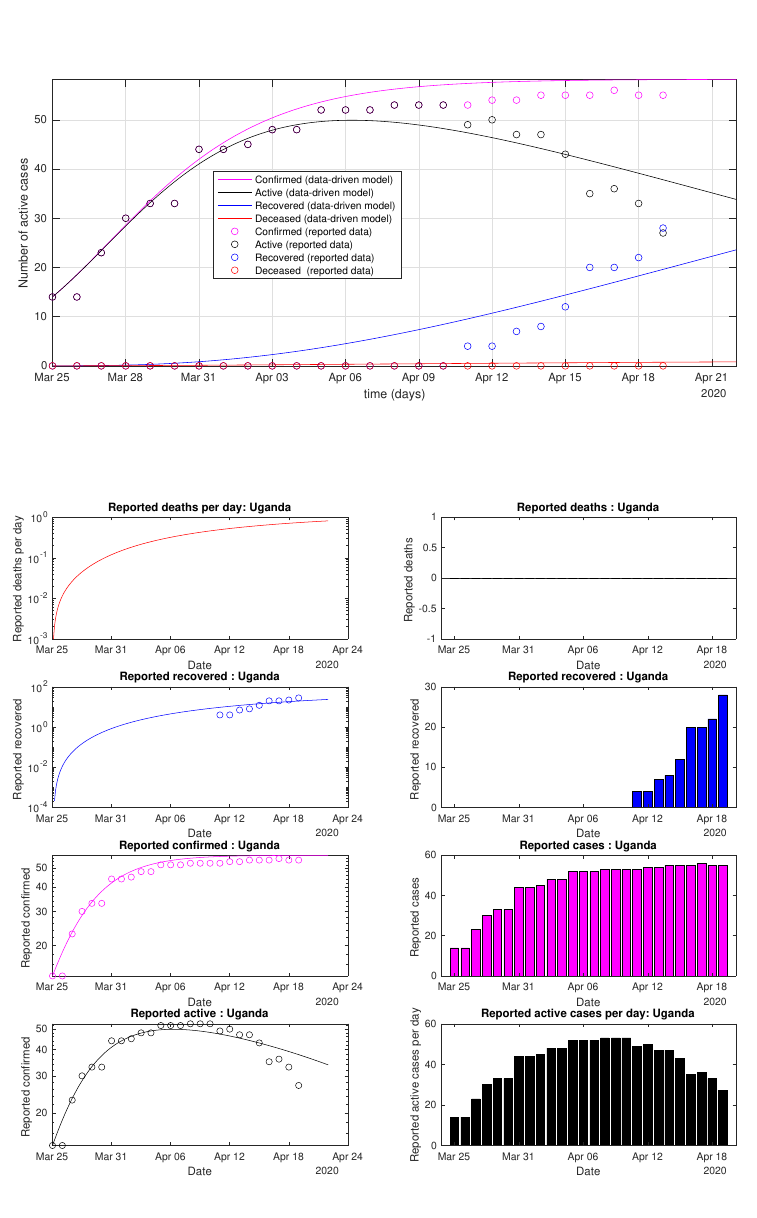
Figure 88. Uganda: data vs.